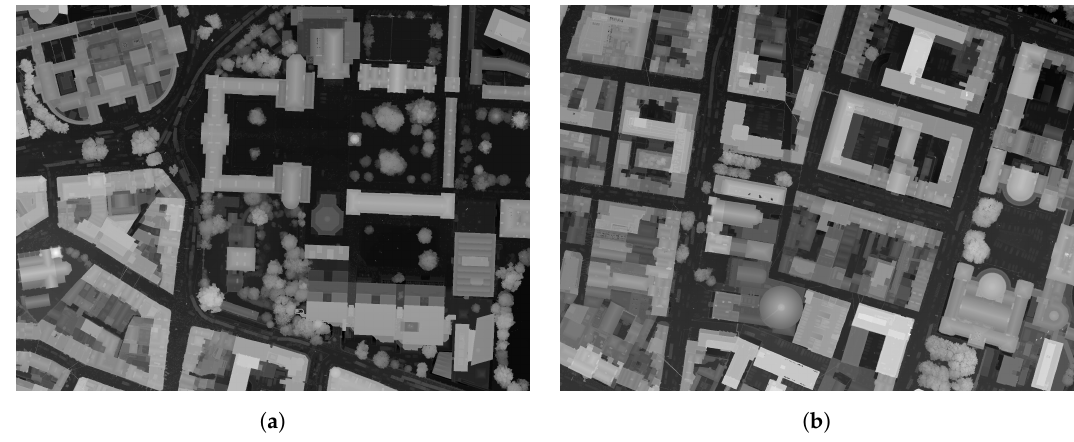
Figure 14. Raster DSMs generated from LiDAR point data for: ( a ) Trinity College, and ( b ) Dawson Street study areas. Cell size is equal to 10 cm in both